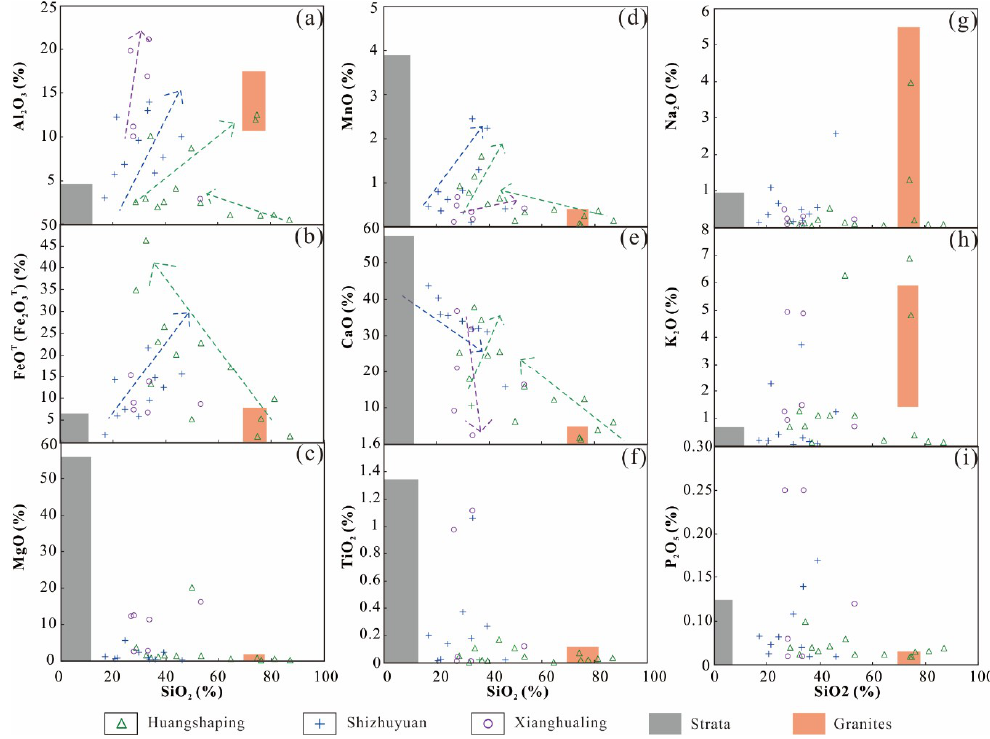
Figure 6. Correlation plots of skarn oxide compositions, compared to those of granites and strata of the Huangshaping, Shizhuyuan and Xianghualing deposits. ( a ) SiO 2 vs. Al 2 O 3 diagram; ( b ) SiO 2 vs. FeO T (Fe 2 O 3T ) diagram; ( c ) SiO 2 vs. MgO diagram; ( d ) SiO 2 vs. MnO diagram; ( e ) SiO 2 vs. CaO diagram; ( f ) SiO 2 vs. TiO 2 diagram; ( g ) SiO 2 vs. Na 2 O diagram; ( h ) SiO 2 vs. K 2 O diagram and ( i ) SiO 2 vs. P 2 O 5 diagram. Colored arrows show correlation trends for skarns (color coded to match data points). The